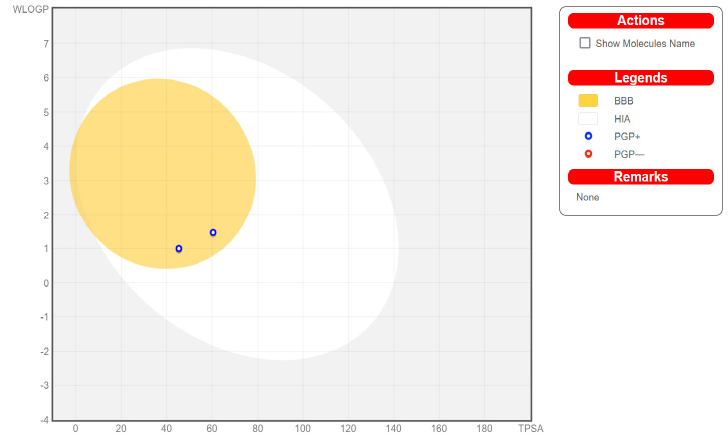
Figure 24. Boiled-egg diagram for all compounds.